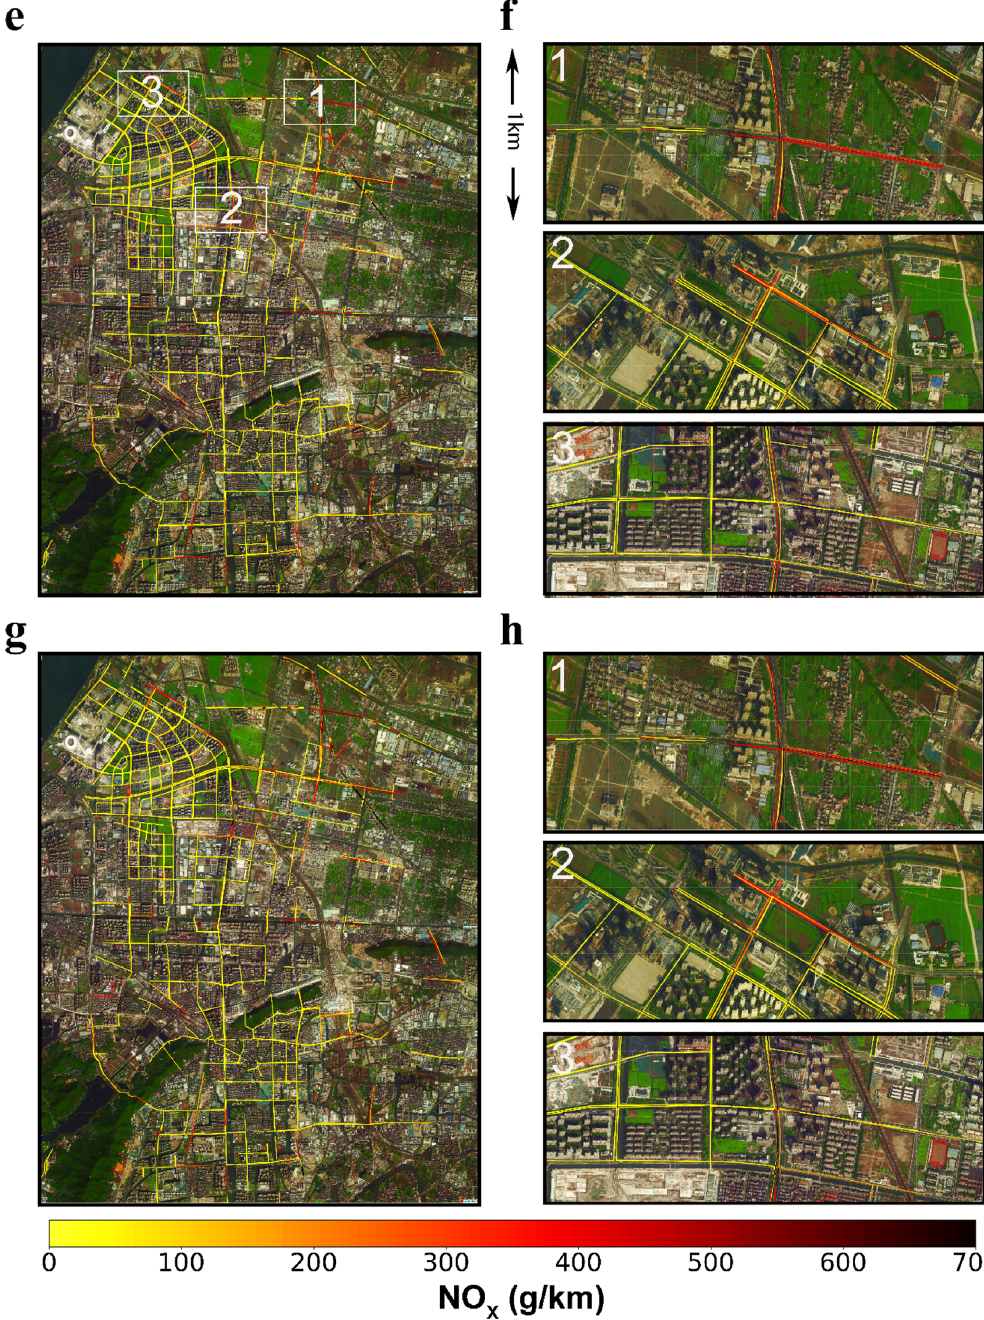
Figure 5. Hyperfine-resolution mapping of on-road vehicle emissions. (a) Hourly average on-road vehicle NO x emissions for each road segment based on 2-month traffic monitoring data for the entire district and (b) for three indicative 2.5km 2 urban zones therein. The panels (c) and (d) are as the same as (a) and (b) but for the hourly average emissions during the morning and evening rush hours (from 07:00 to 09:00 and from 16:30 to 18:30 local time) on weekdays (from Monday to Friday). The panels (e) and (f) are as the same as (a) and (b) but for the hourly average emissions of HDTs and HDVs. The panels (g) and (h) are as the same as (a) and (b) but for the hourly average emissions of HDTs and HDVs during the morning and evening rush hours on weekdays. The indicative zones are marked by white rectangles in (a) . Map data © 2021, Gaode